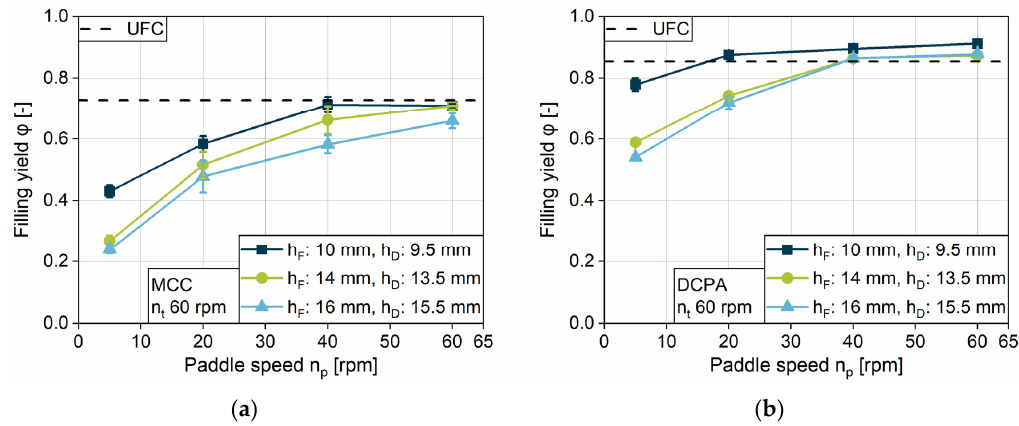
Figure 10. Filling yield for different fill depths for ( a ) MCC and ( b ) DCPA.